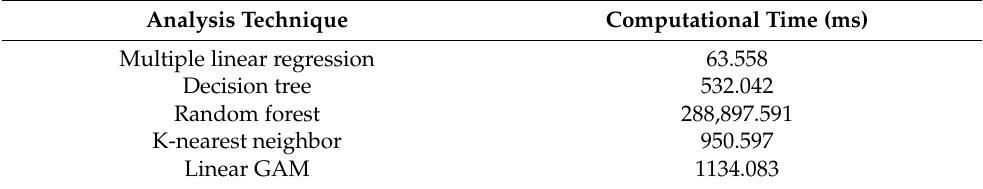
Table 4. Computational time